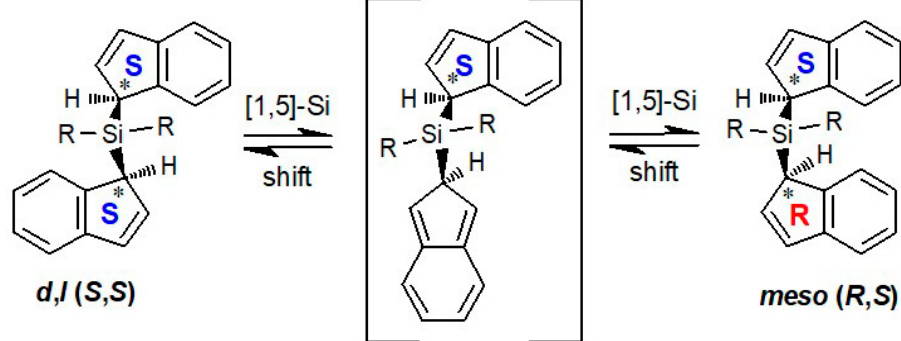
Scheme 3. Interconversion of diastereomers of bis(indenyl)dimethylsilane.